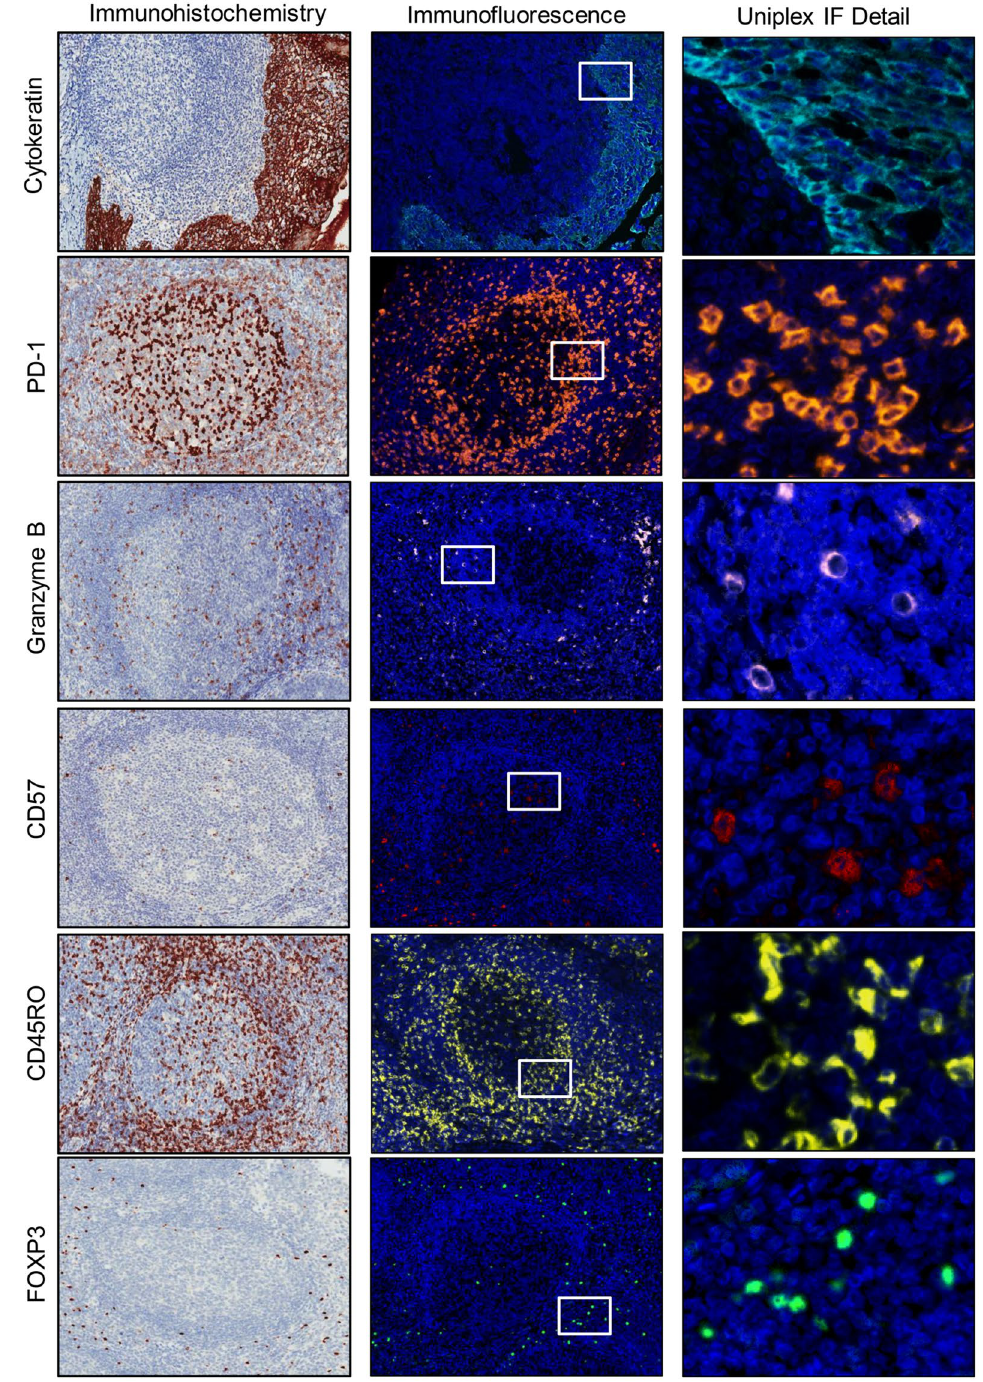
Figure 2. Microphotographs of representative examples of validation from uniplex IHC ( left panels ), uniplex IF tumor-associated immune cell expression ( middle panels ), and details of uniplex IF in tonsil tissue ( right panels ). Immune panel 2: AE1/AE3 (cytokeratin-positive), PD-1–positive, granzyme B–positive, natural killer cell (CD57-positive), memory T cell (CD45RO-positive), and regulatory T cell (FOXP3-positive). × 200 magnification and high-power magnification of the positive